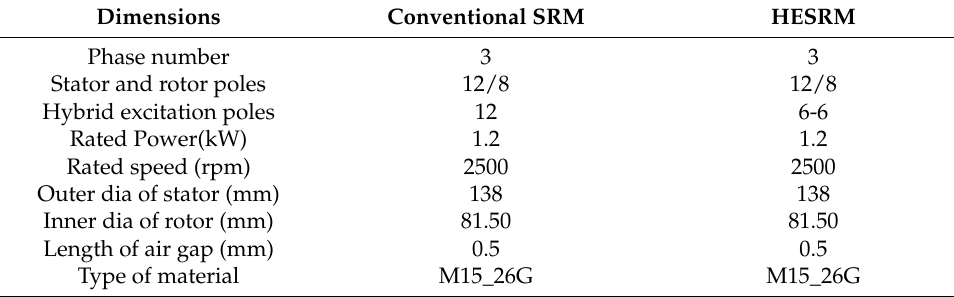
Table 1. Main dimensions and parameters of two